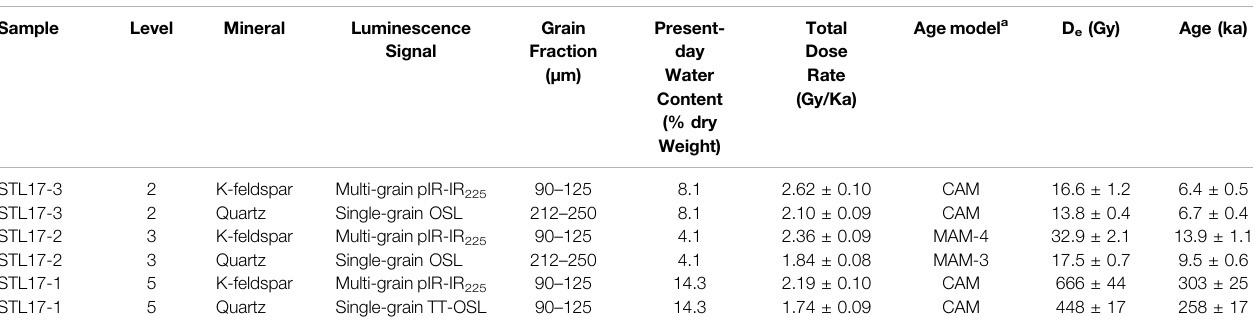
TABLE 1 | Final luminescence ages obtained for the El Sotillo (excavation sector B) samples.